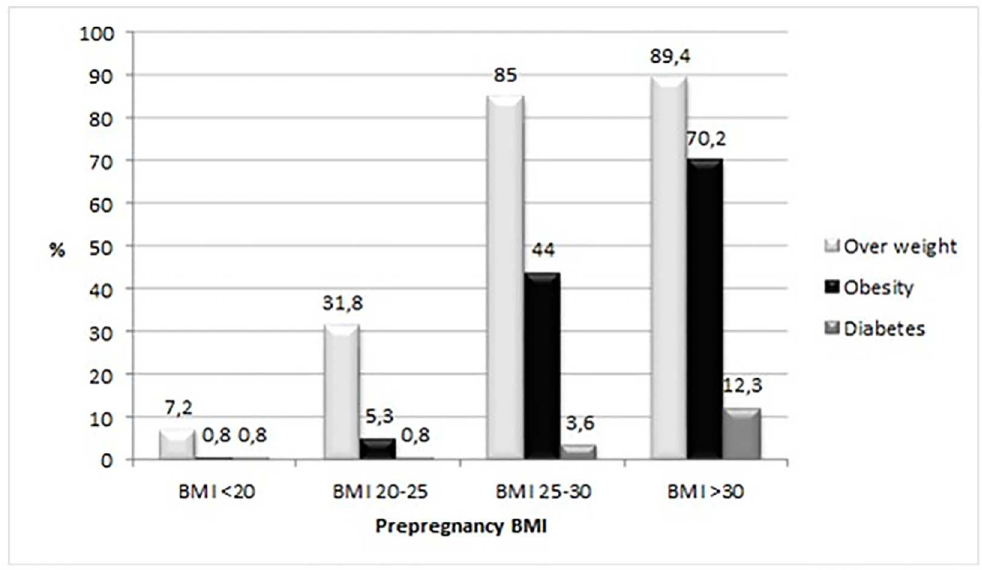
Fig 1. Frequency of different diseases10–17 yearsafter pregnancy by BMI